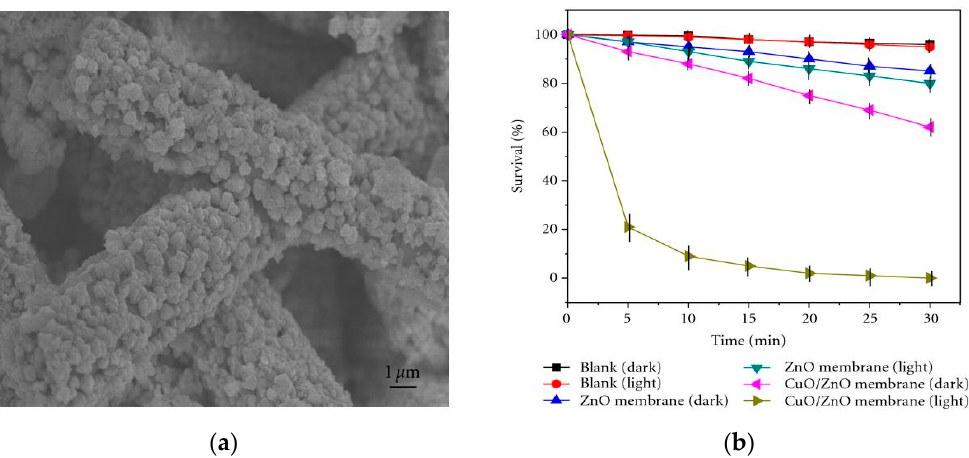
Figure 42. ( a ) SEM image showing ZnO nanorods decorated with CuO. ( b ) Survival rate vs visible light irradiation time curves of E. coli treated with CuO / ZnO membrane and ZnO membrane.